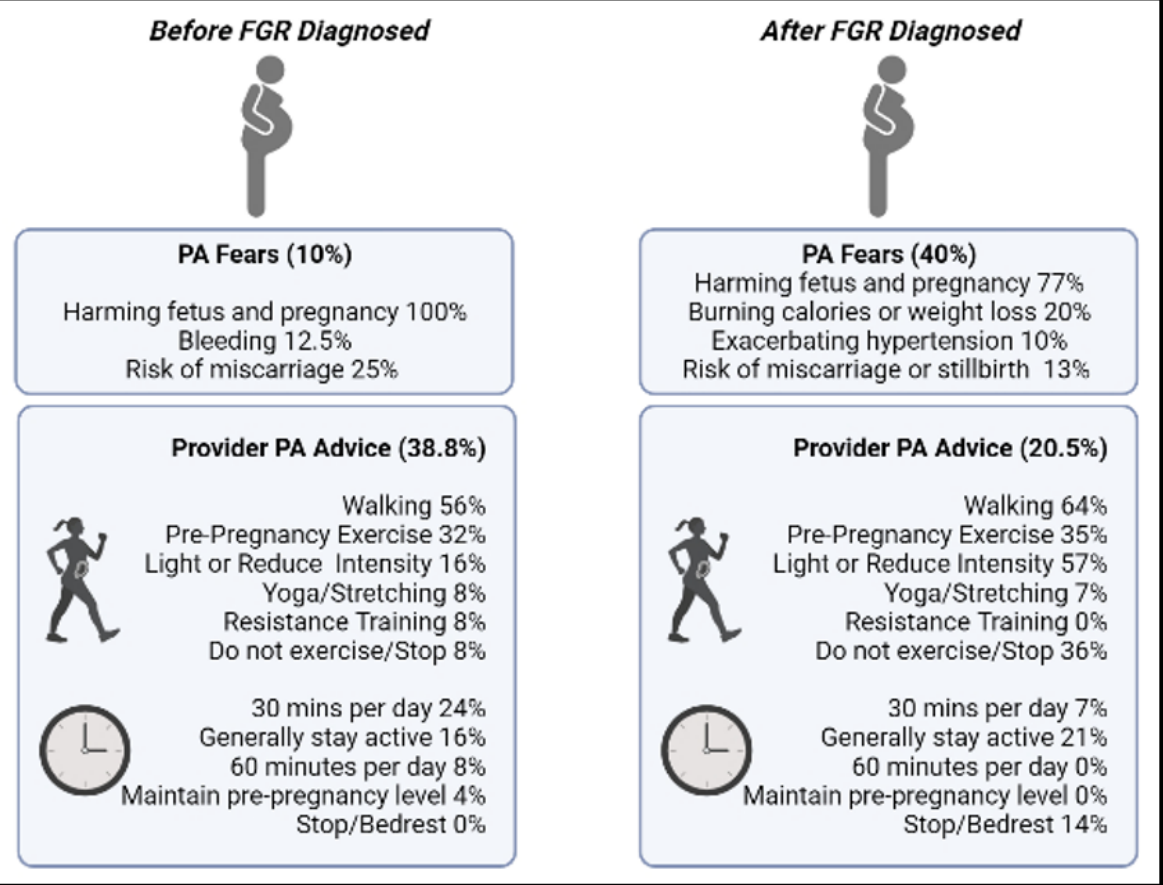
Figure 2. Summary of content analysis findings highlighting physical activity fears and healthcare provider advice for physical activity before and after FGR diagnosis. Nonbold text and percentages refer to respondents among those who indicated ‘yes’ to the variable (i.e., fears and receiving advice) and provided an example. FGR—fetal growth restriction; PA—physical activity; bold text and per- centages refer to full sample. This figure was created with BioRender.com (accessed on 8 April 2022).